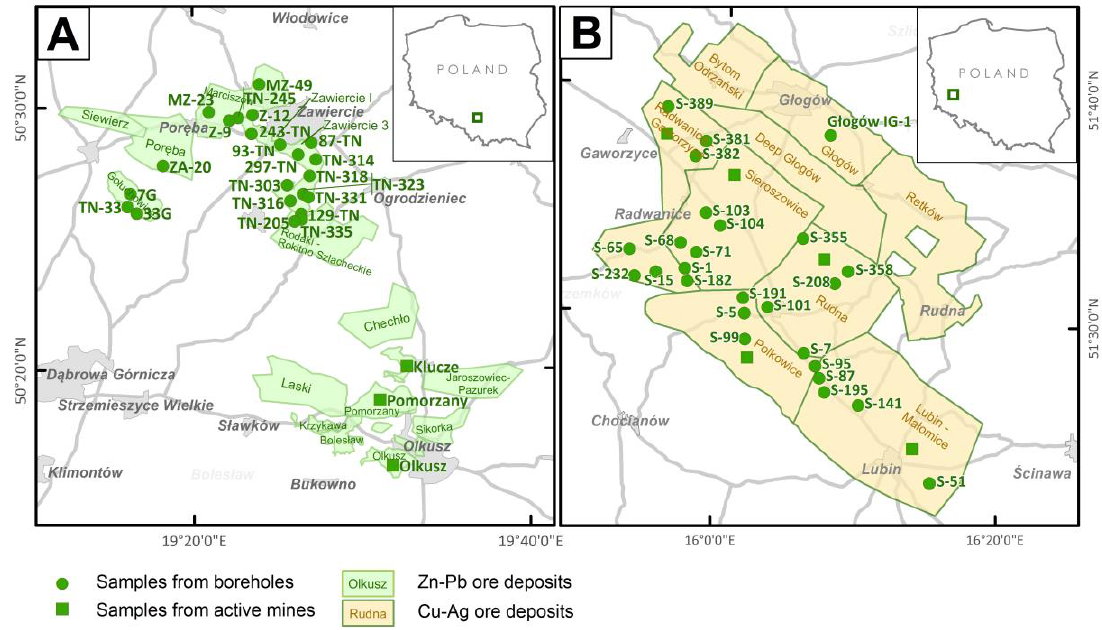
Figure 10. Location of boreholes sampled and studied in the Zn-Pb ( A ) and Cu-Ag ( B ) deposits.